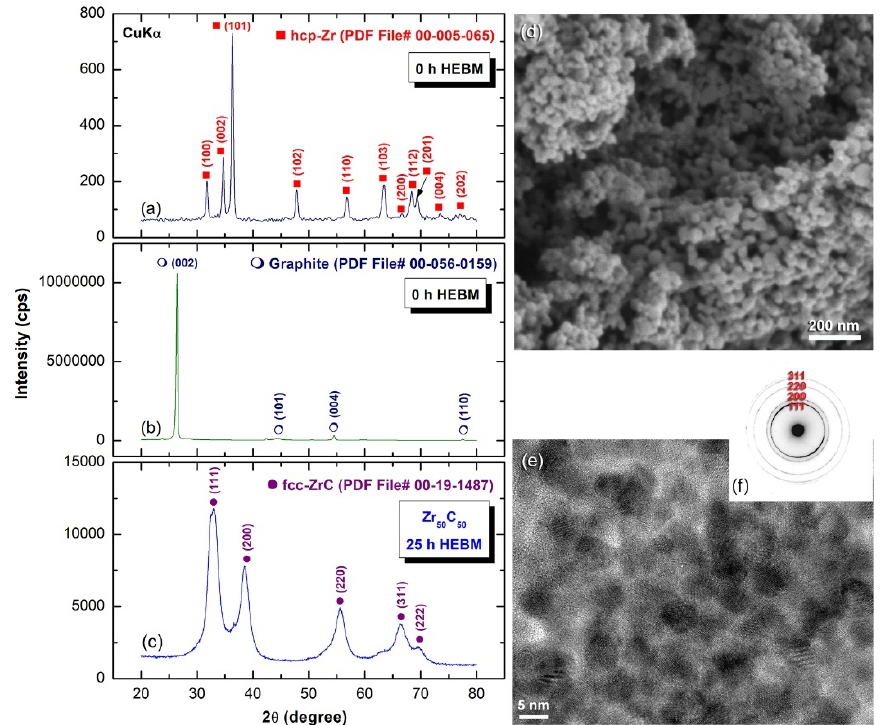
Figure 4. XRD patterns of ( a ) as-received hcp-Zr and ( b ) graphite powders. The XRD pattern of equiatomic fcc-ZrC nanopowders obtained after 25 h of high-energy ball milling (HEBM) is dis- played in ( c ). The morphological characteristics of as-prepared fcc-ZrC powders are indexed in ( d ) and ( e ) by FE-SEM and FE-HRTEM, respectively. The nanobeam diffraction pattern (NBDP) taken from the middle zone of ( e ) is presented in ( f ). the middle zone of ( e ) is presented in ( f